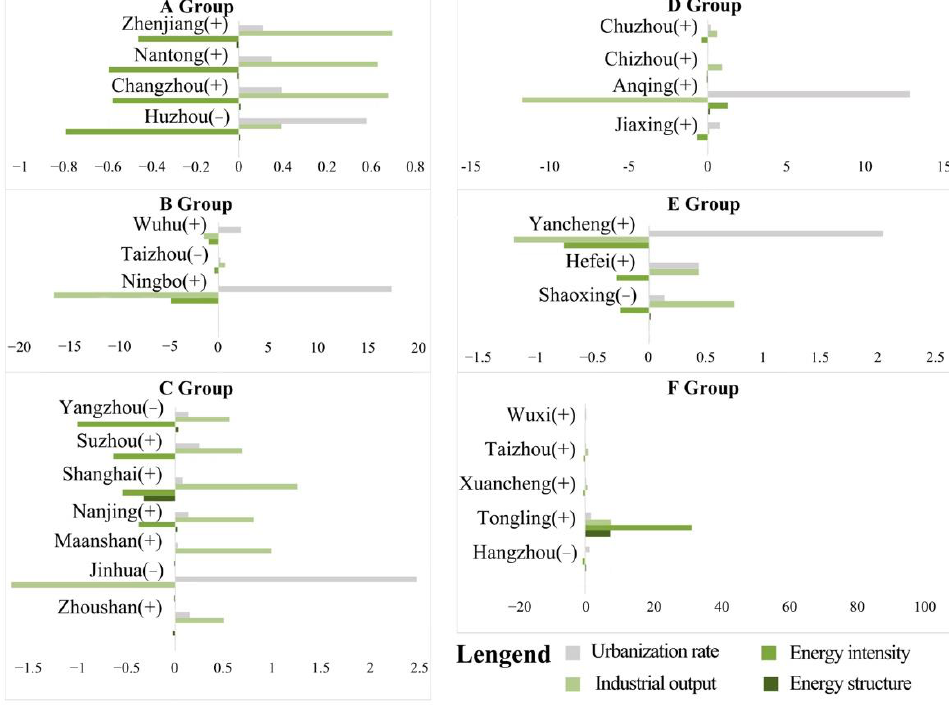
Figure 12. Cluster analysis results in the third five years (2010 –